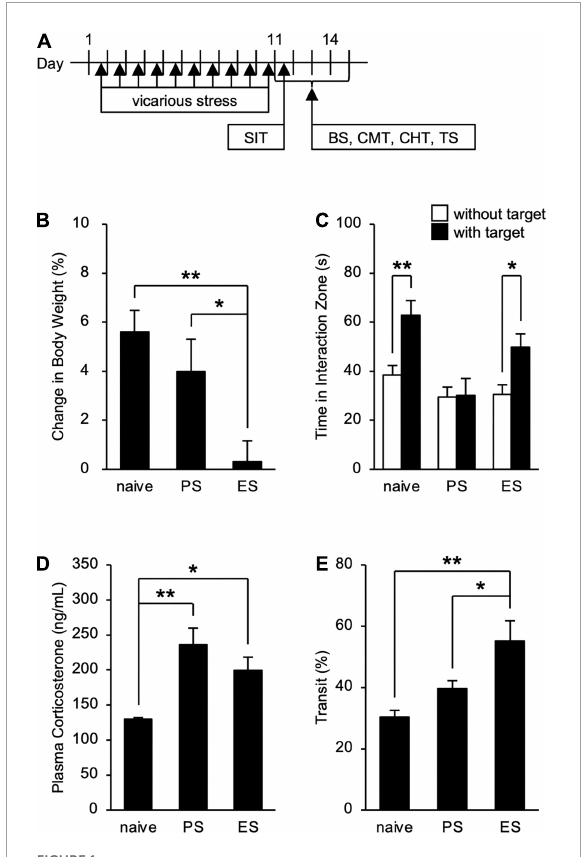
FIGURE1 Effects of chronic social defeat stress (cSDS) and chronic vicarious social defeat stress (cVSDS) on the physiological and behavioral responses of mice. (A) Schematic representations of experimental designs. SIT: social interaction test; BS: blood sampling; CMT: charcoal meal test; CHT: capsaicin-induced hyperalgesia test; TS: tissue sampling. (B) Effect of cSDS and cVSDS on body weight gain. Data are presented as means ± s.e.m., and analyzed using one-way factorial ANOVA, followed by Bonferroni’s post hoc test. * p < 0.05, ** p < 0.01. naive, n = 24; PS, n = 24; ES, n = 28. (C) Time spent in